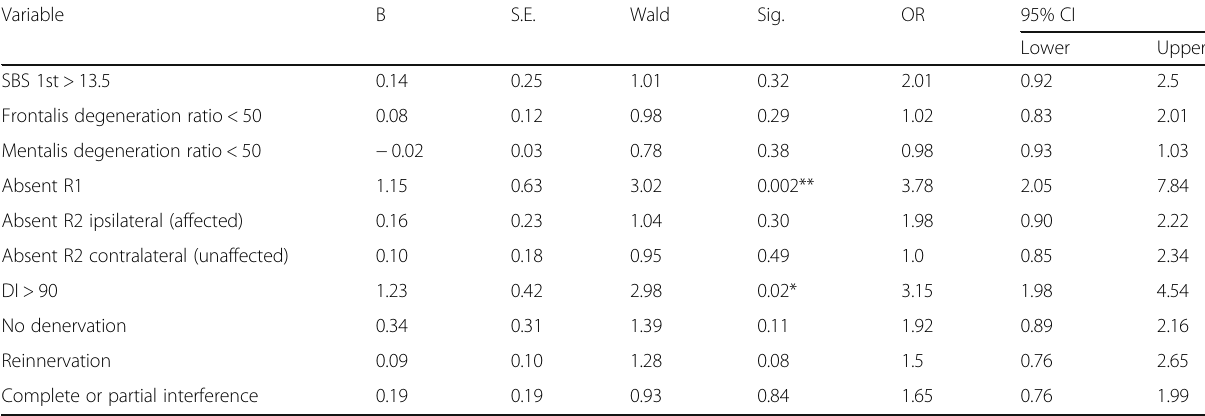
Table 5 Logistic regression analysis for significant predictors for Bell ’ s palsy recovery